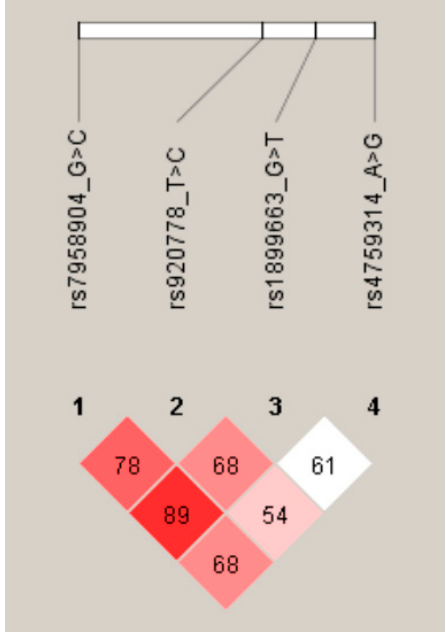
Figure 1. Linkage disequilibrium between HOTAIR loci.